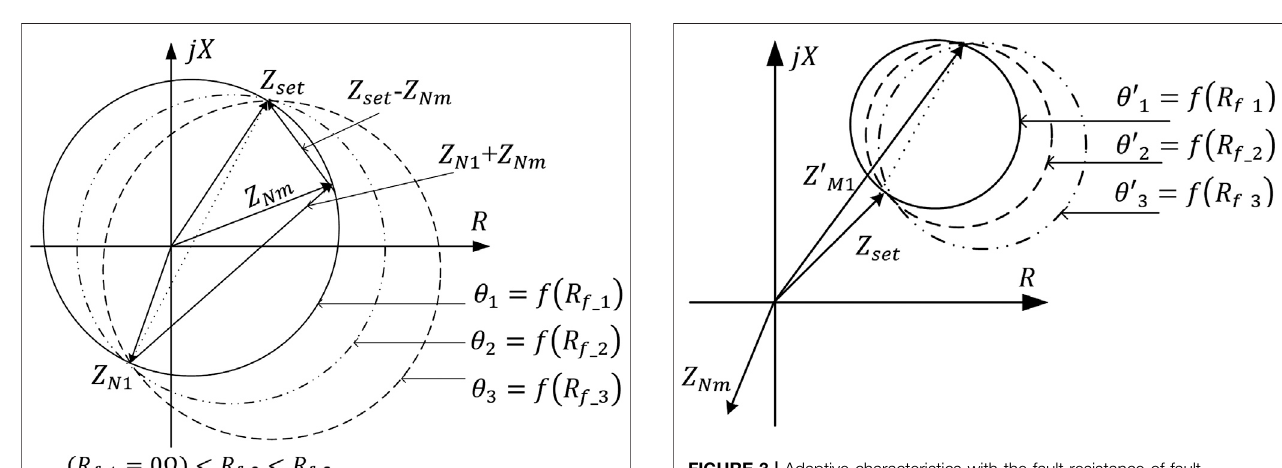
FIGURE 3 | Adaptive characteristics with the fault resistance of fault component positive sequence voltage polarized impedance relay when backward fault